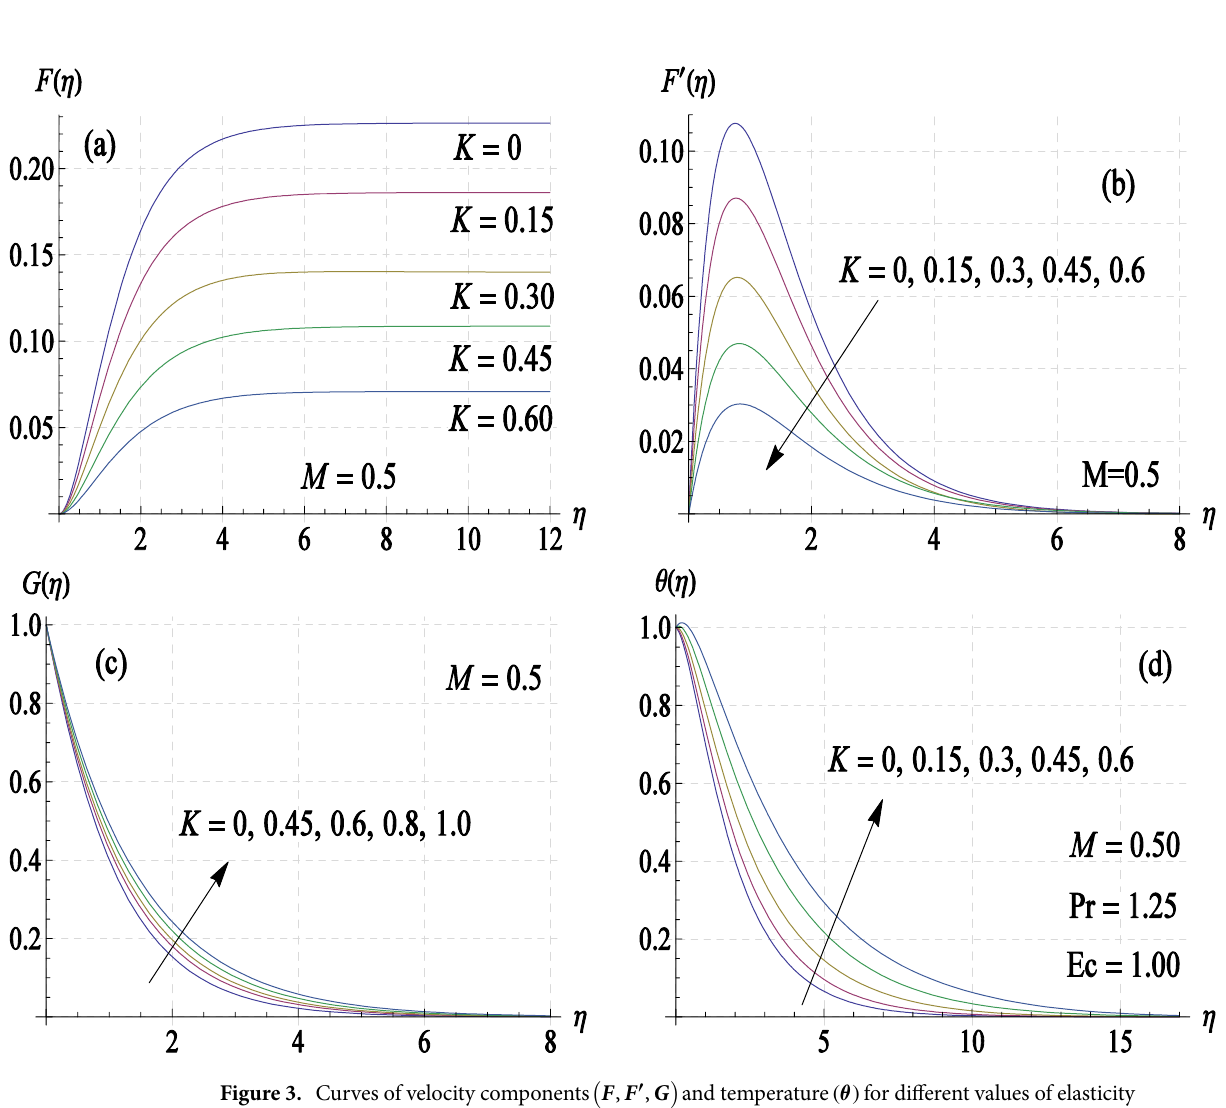
Figure 3. Curves of velocity components parameter K